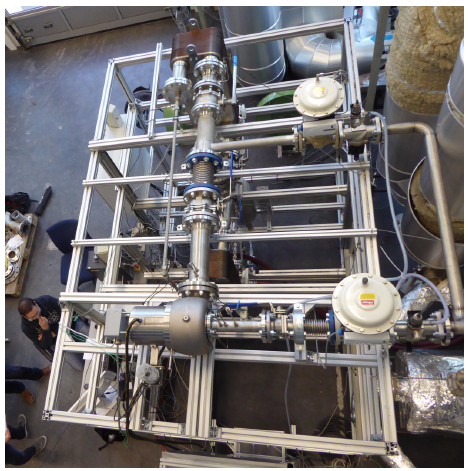
Figure 3. Photo of the ORC